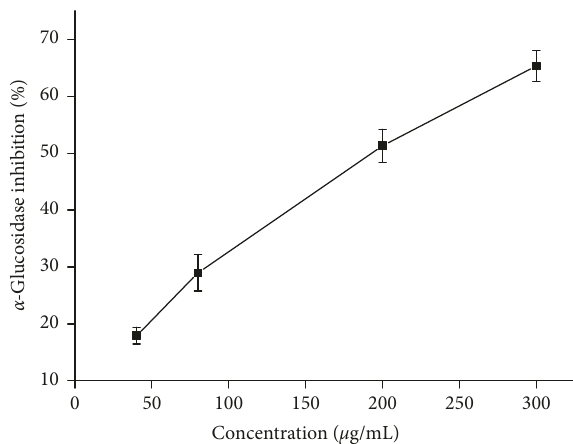
Figure 9: Dose-response curve for α -glucosidase inhibitory activity of epicatechin. Data are expressed as mean